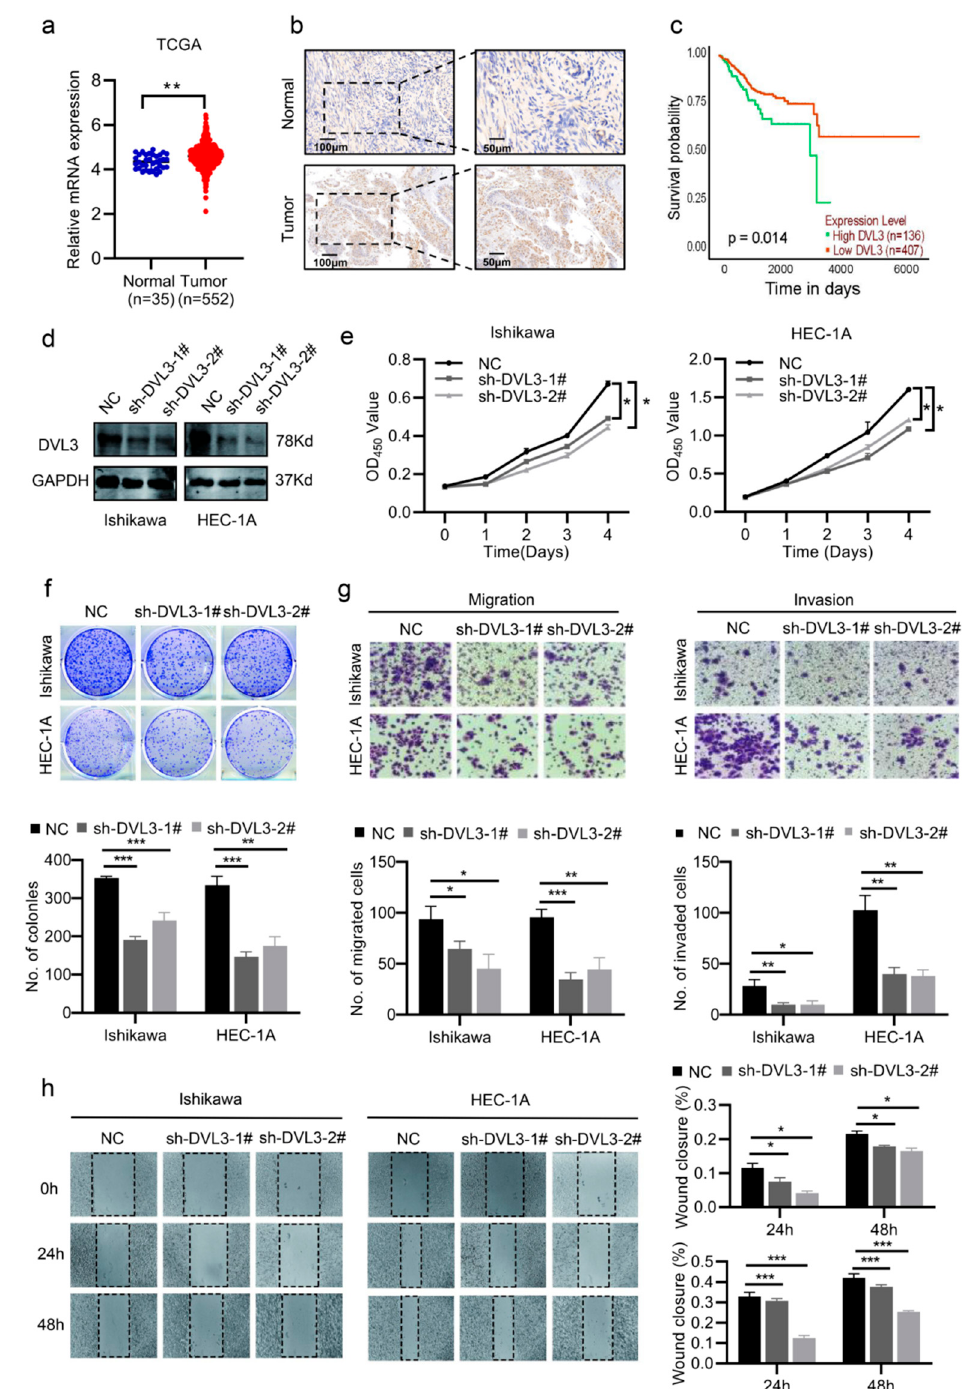
Figure 6. DVL3 promotes EC cell proliferation, migration, and invasion. ( a ) The mRNA levels of DVL3 were measured using data from TCGA-UCEC. ( b ) The IHC of DVL3 expression in EC and normal tissues in the Ren Ji cohort. Scale bar, 50 µm. ( c ) The survival of patients with EC was associated with the expression of DVL3 based on TCGA. ( d ) The efficacy of DVL3 knockdown was measured using Western blotting. ( e , f ) The CCK-8 and colony-formation assays (200 × ) showed that the proliferation of EC decreased after DVL3 knockdown. ( g , h ) The migration and invasion abilities of DVL3-knockdown EC cells were measured using transwell and wound-healing assays (200 × ). * p < 0.05, ** p < 0.01, *** p < 0.001.